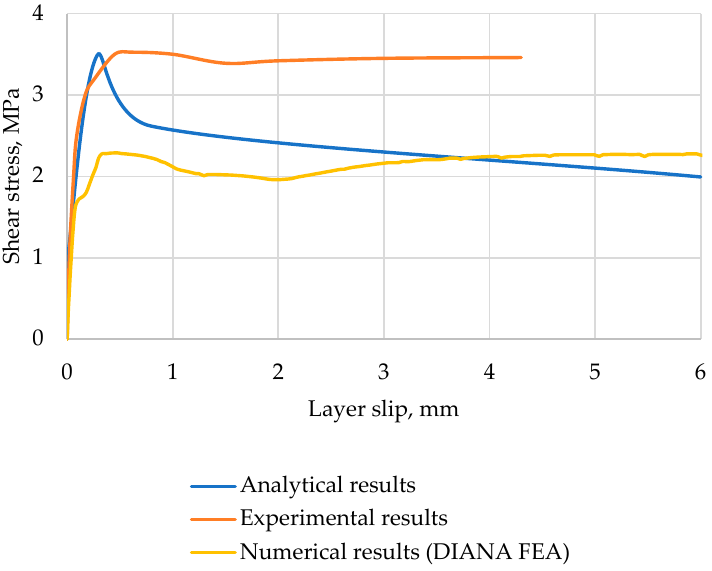
Figure 8. Shear stress–layer slip curves of specimen S-C65L30-6D8-Ba.